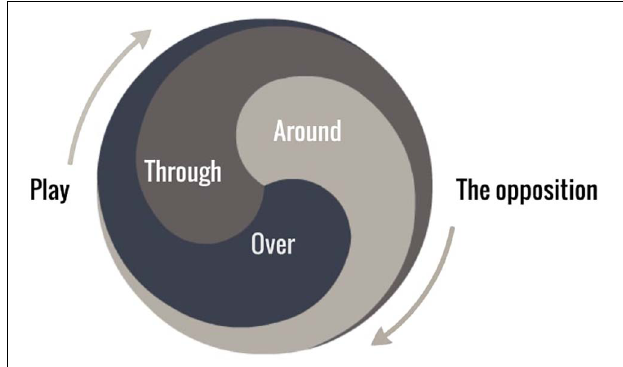
FIGURE 1 | An illustration of the constitutive and nested relation of skilled intentions to play through, around and over the opposition in